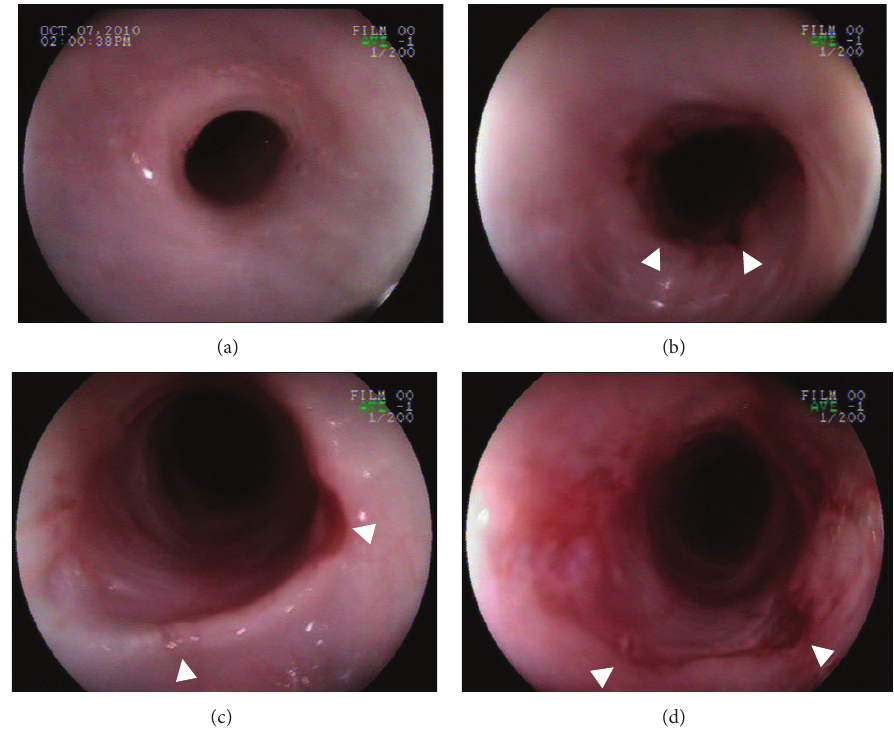
Figure 2: Endoscopic appearance of the esophageal stricture at re-examination on day 53 after 4 previous dilations. A band of fibrous tissue is present at the site of stricture extending from 7 o’clock to 2 o’clock resulting in a lumen diameter of 4mm (a). After initial dilation with an 8mm cutting balloon, multiple defects (white arrowheads) are noted in the fibrous band, now at 3 o’clock to 9 o’clock (b). Subsequent serial dilations with conventional dilation balloons resulted in further disruption of the fibrous band at these defects (c) and more diffuse mucosal tearing resulting in a lumen diameter of 10mm (d).